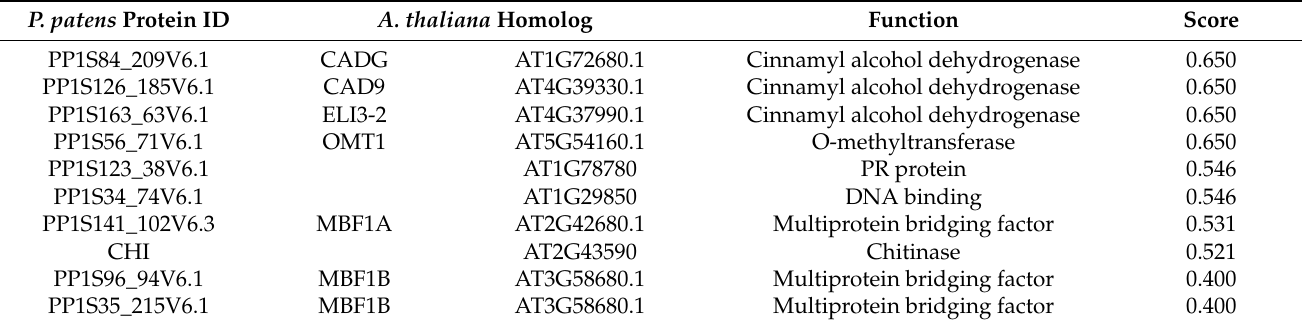
Table 6. List of proteins PpaPrx19 (PP1S306_37V6.1) has interactions with, based on STRING. P. patens Protein